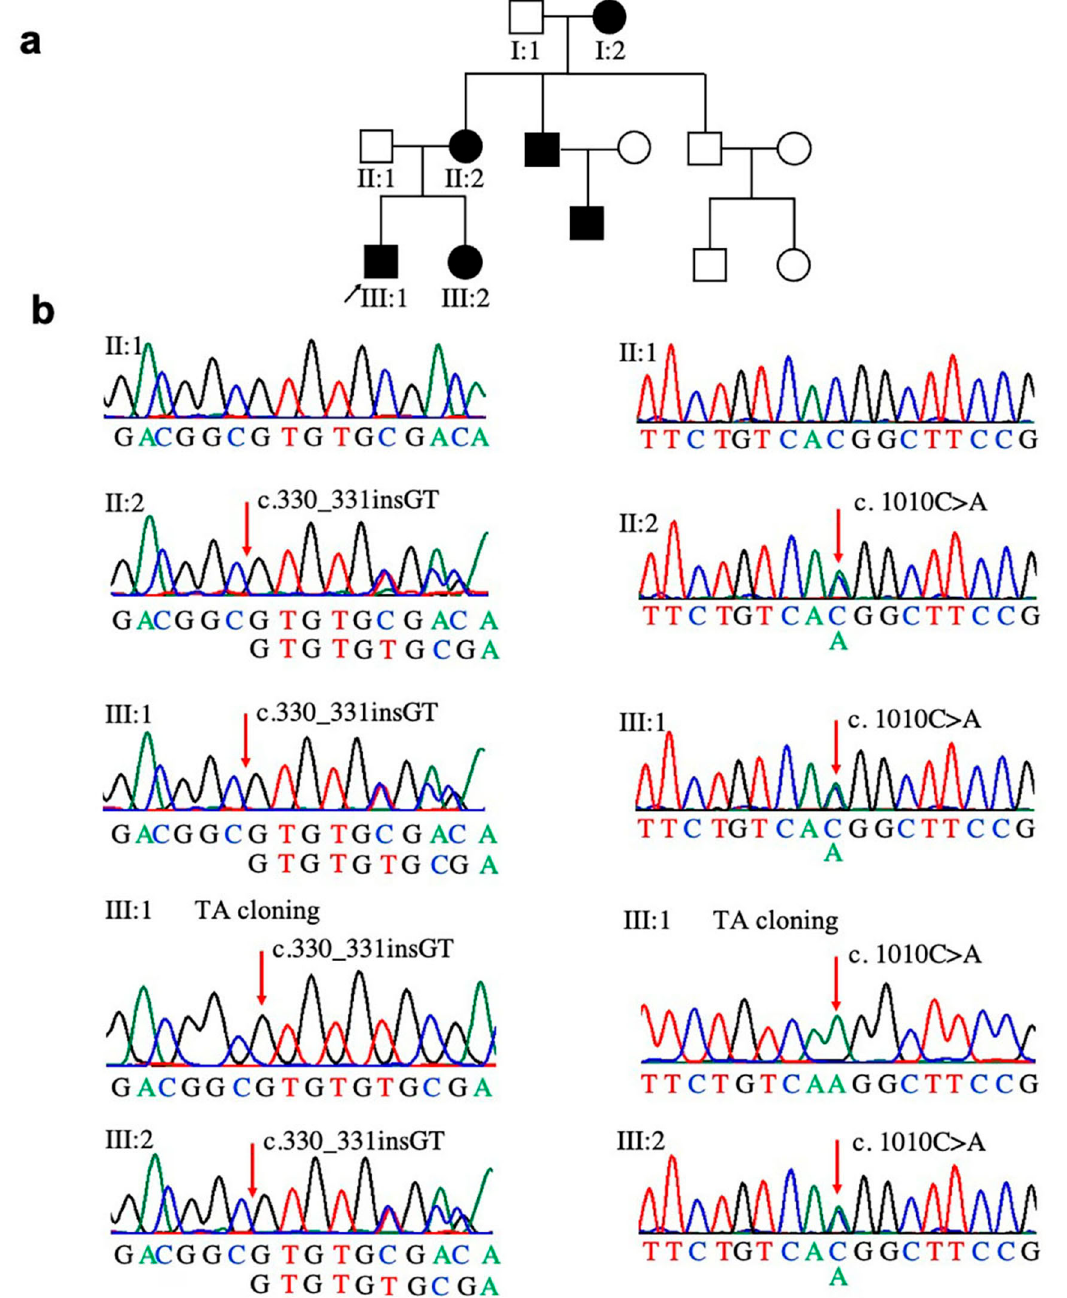
Figure 1- Identification of a compound heterozygous PAX9 variant in a Chinese family with non-syndromic oligodontia. (a) The pedigree of the Chinese family. The black arrow indicates the proband. (b) DNA sequencing chromatograms of the family and TA cloning sequencing of the proband showing a new frameshift variant c.330_331insGT (p.D113Afs*9) in exon 2 and a new missense variant c.1010C>A (p.T337K) in exon 4 (reference sequence